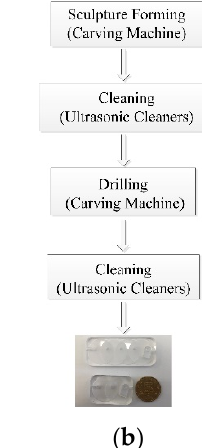
Figure 3. Processing sequence of the pump body and valve. ( a ) Processing sequence of the valve. ( b ) Processing sequence of the pump body.